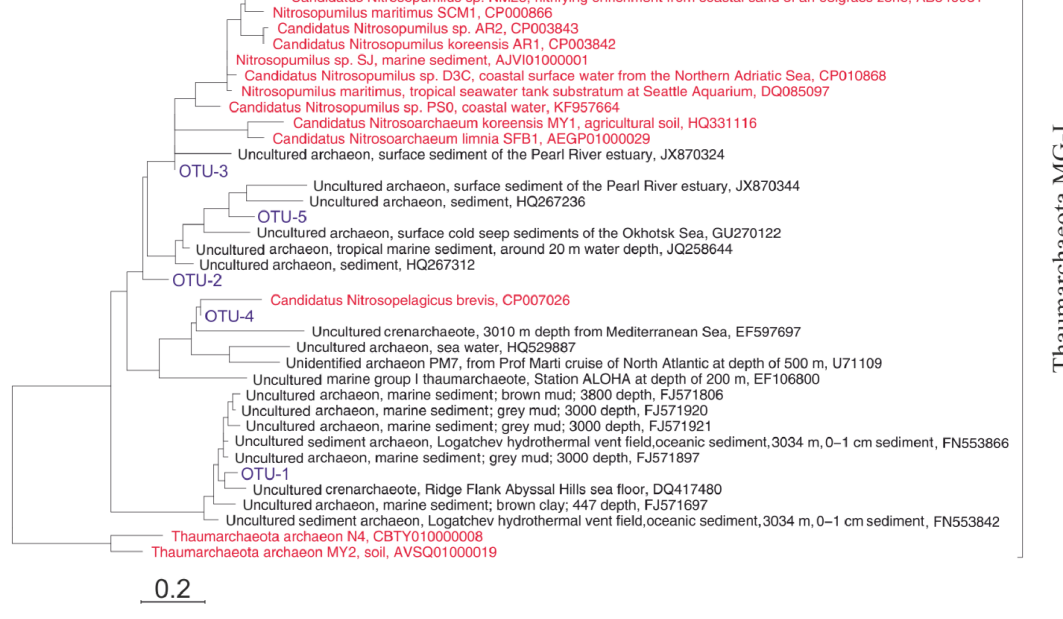
Figure 3. Maximum likelihood phylogenetic tree of MG-I OTUs recovered within the sediment based on the 16S rRNA gene (colored in blue). Sequences from cultured representatives of Thaumarchaeota MG-I are indicated in red. Environmental sequences of MG-I members are indicated in black with their origin specified. The relative abundances of the various OTUs are listed in Table 4. The scale bar represents a 2% sequence